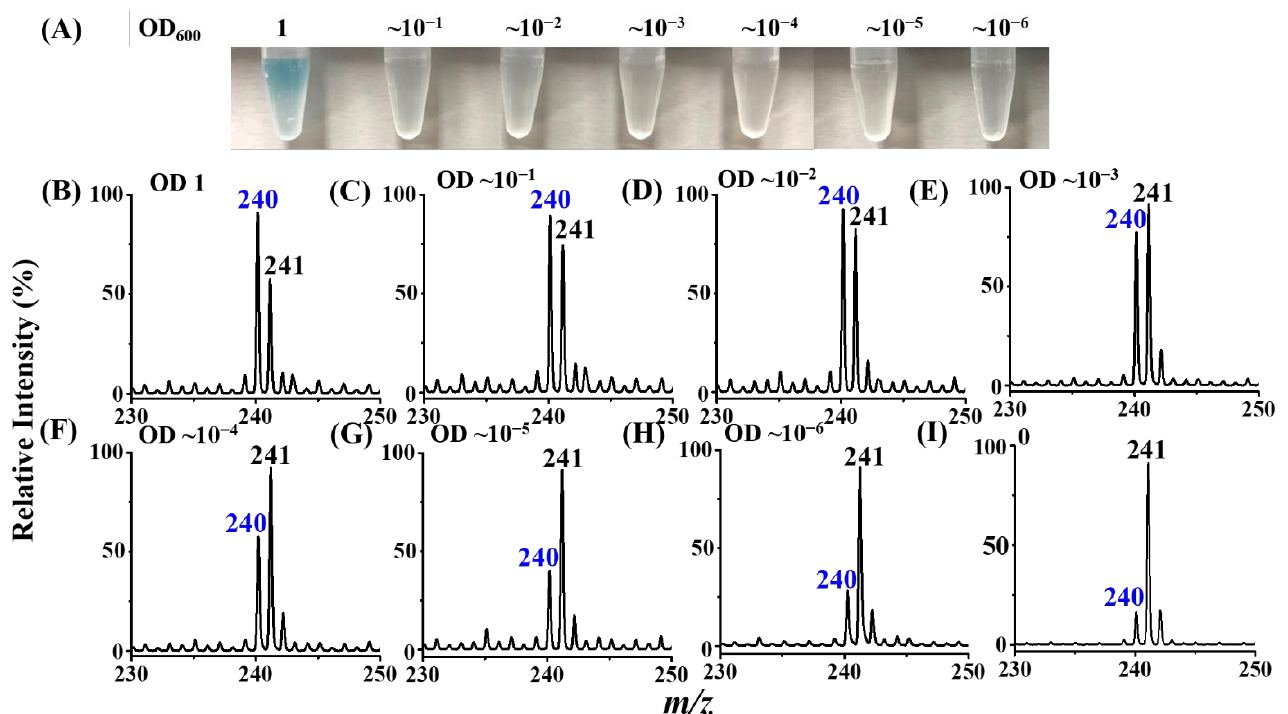
Figure 2. ( A ) Photograph of the samples (0.2 mL) containing E. coli O157:H7 at different concentra- tions, from a serial dilution of OD 600 of 1 with a dilution factor of 10 prepared in ammonium acetate buffer (pH 4.5, 10 mM) and reacted with TMB (1 mg mL − 1 , 2 µ L) in the presence of H 2 O 2 (100 mM, 2 µ L) for 30 min. ( B – H ) Corresponding C-API mass spectra of the samples shown in Panel A. All the samples were 100-fold diluted with ethanol/deionized water (2:1, v / v ) prior to C-API-MS analysis. A droplet of sample (5 µL) was used for MS-analysis. ( I ) Mass spectrum of the blank sample without containing bacteria.